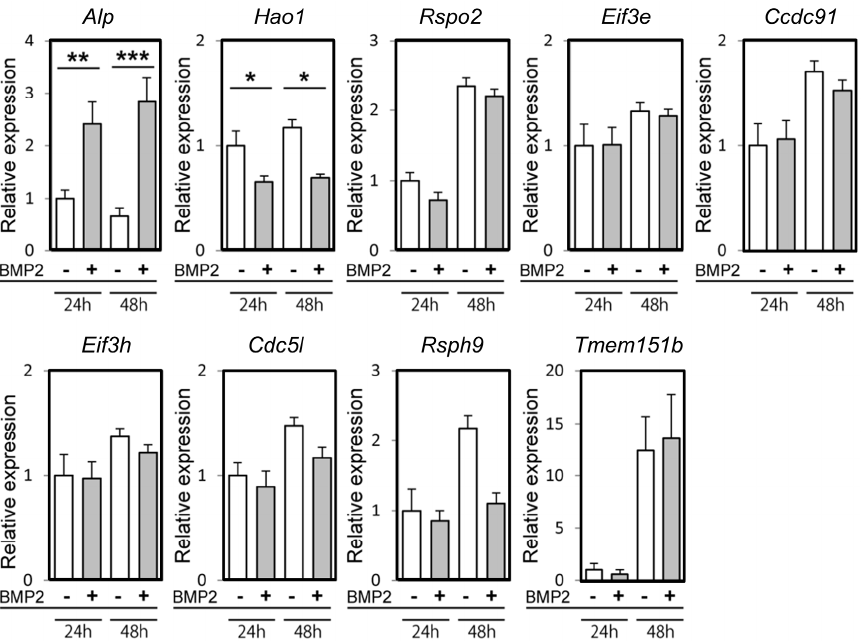
Figure 1. Hao1 expression was downregulated during osteoblastic differentiation of fibroblasts. Expression of Alp and eight candidate genes in mouse embryonic fibroblasts cultured in osteoblastic differentiation conditions (namely, in the presence or absence of 50 ng/mL of BMP2) for 24 or 48 h, as analyzed by real-time PCR. Data represent mean values of indicated parameters ± S.D. (* p < 0.05; ** p < 0.01; *** p <